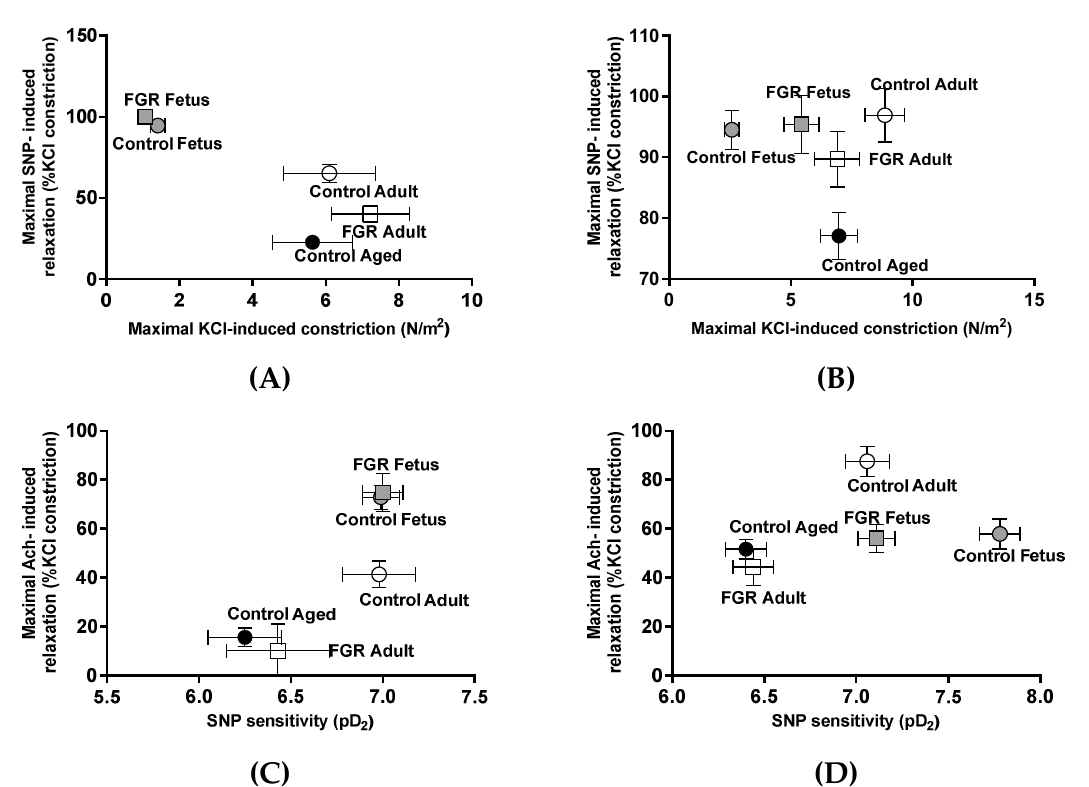
Figure 4. Effects of fetal growth restriction (FGR) in life-course changes in the ex vivo contractile and relaxing responses in guinea pig carotid and femoral arteries. Maximal contractile capacity (KCl- induced constriction) and maximal relaxation to exogenous NO in carotid ( A ) and femoral ( B ) arteries from control and FGR fetus and adults, as well as control aged guinea pigs. Sensitivity to exogenous NO (pD 2 ) and maximal relaxation response to acetylcholine in carotid ( C ) and femoral ( D ) arteries from control and FGR fetus and adults, as well as control aged guinea pigs. Values derived from Table 2.